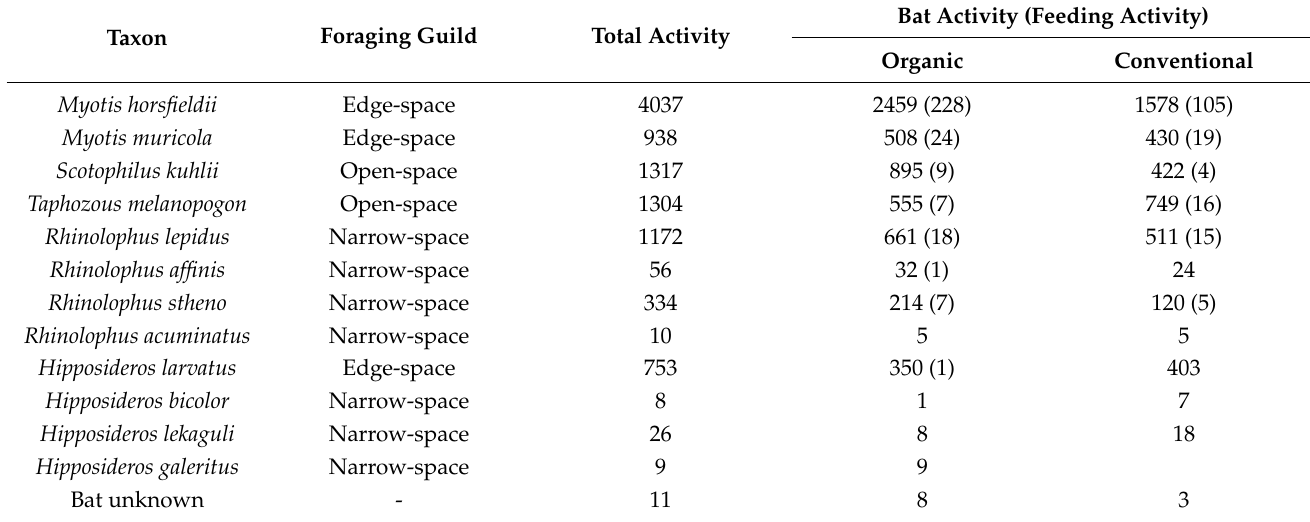
Table 1. Total bat activity (no. of bat passes) and feeding activity (total no. of feeding buzzes) by rice farming type for each bat species and the foraging guild they belong to.